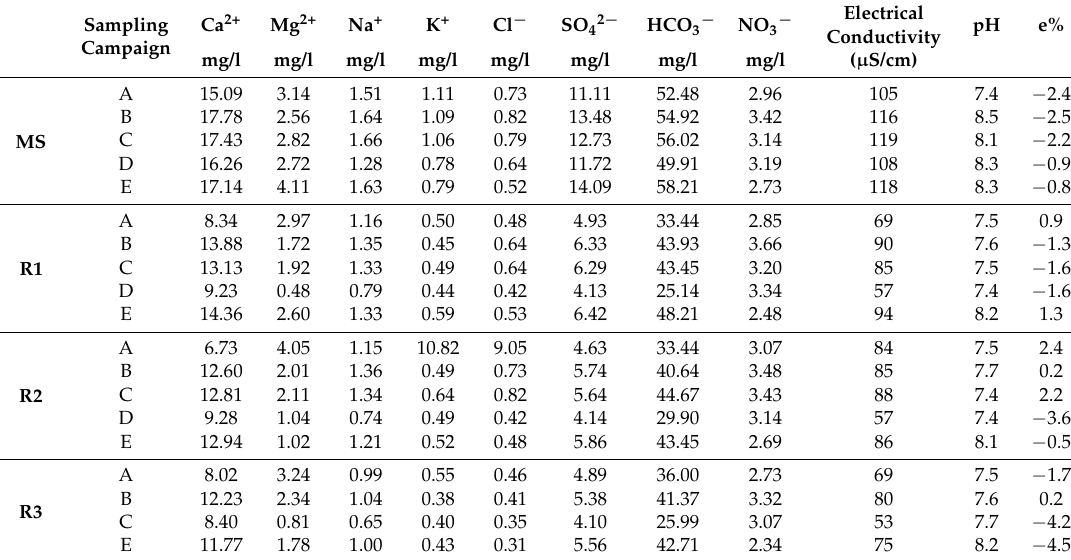
Table 2. Results of the physical-chemical analyses performed in the Montellina Spring sample (MS) and Renanchio Stream samples (R1, R2, and R3). Sampling campaigns are referred to: November 2005 (A), January 2006 (B), February 2006 (C), May 2006 (D), and September 2006 (E); e% represents the accuracy of the result, quantified by calculating the percent